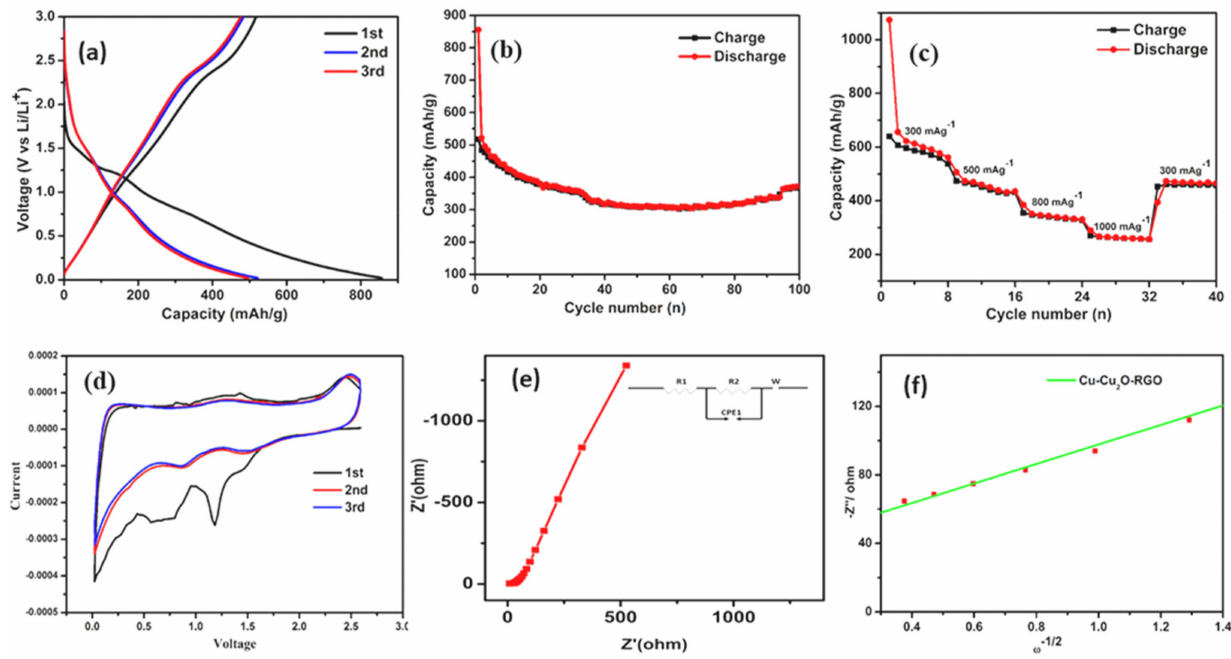
Figure 6. Electrochemical tests relating to the RGO/Cu/Cu 2 O composite electrode: ( a ) charge– discharge profiles at a current density of 500 mA/g; ( b ) cycling performance at 500 mA/g; ( c ) rate performance; ( d ) cyclovoltammetric curves (first three cycles) at a scan rate of 0.1 mV/s; ( e ) EIS spectra recorded at 10 mV; ( f ) relationship between Z’ and ω − 1/2 extrapolated from EIS